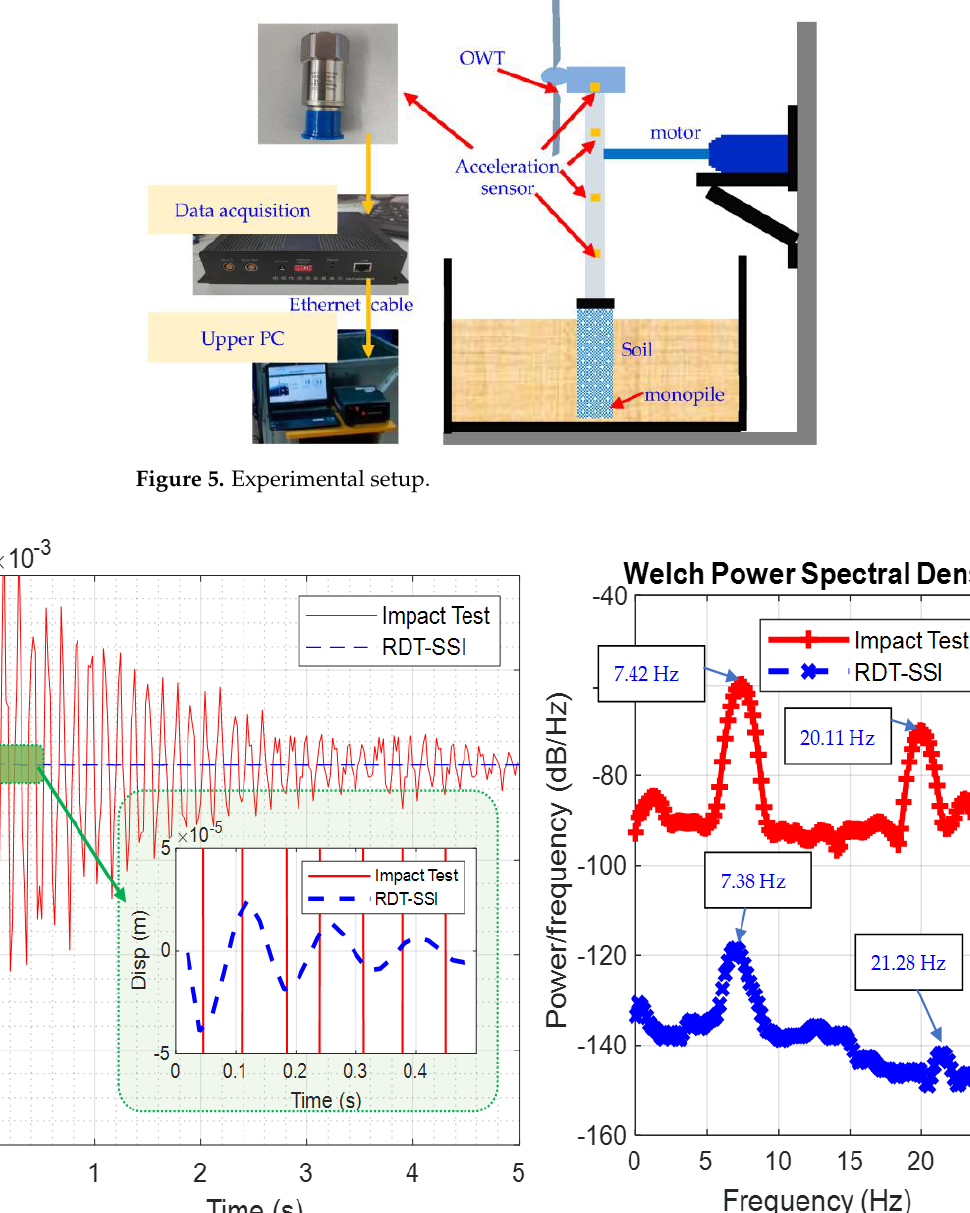
Figure 6. Comparison of impact test and RDT result: ( a ) time-domain result and ( b ) frequency-domain result.